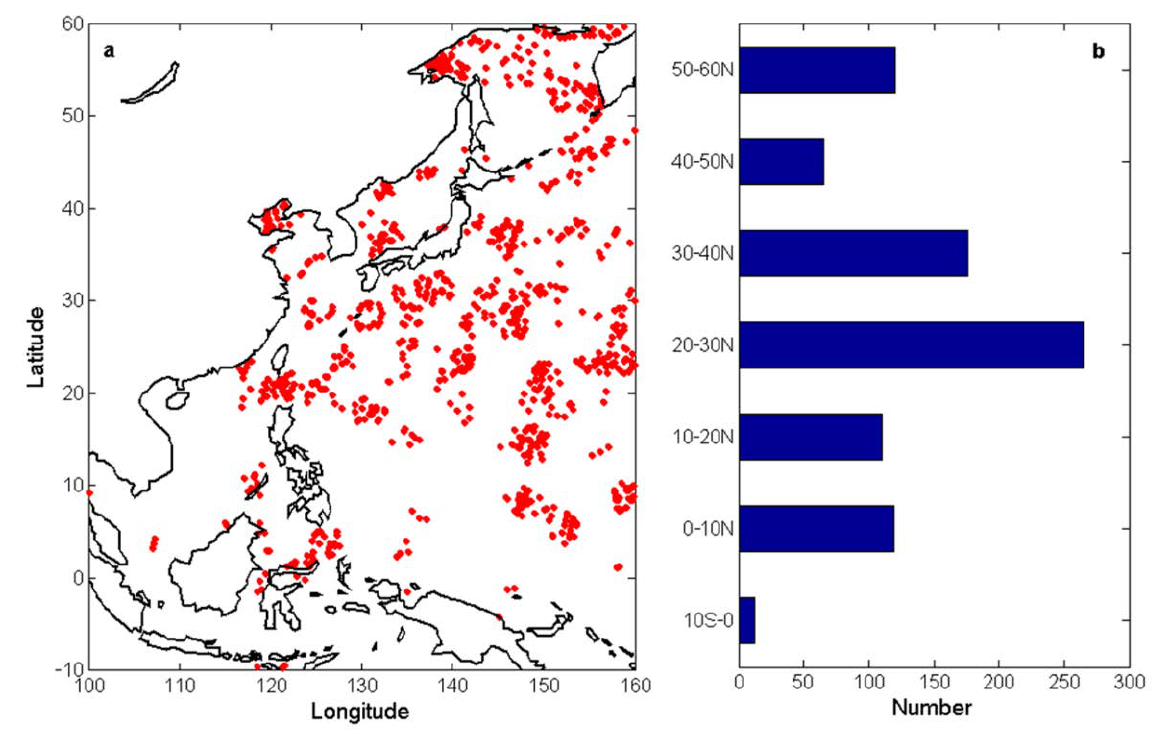
Figure 13. ( a ) The spatial distribution of retrieval samples between the HIRAS and RO data. ( b ) The count of retrieval samples in 10 ◦ latitudinal bands.